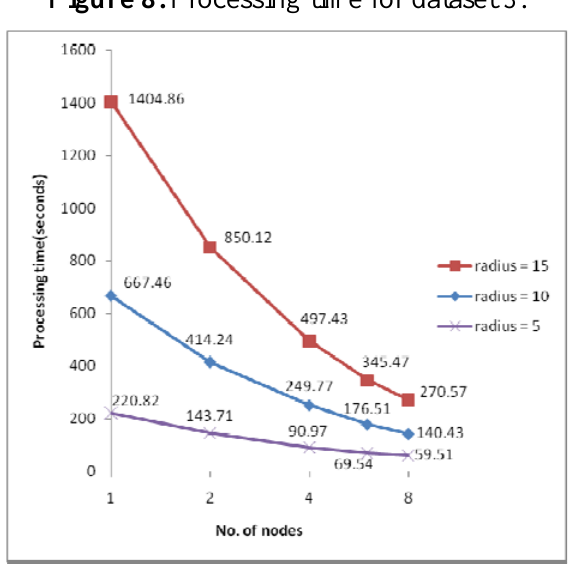
Figure 8. Processing time for dataset 3.